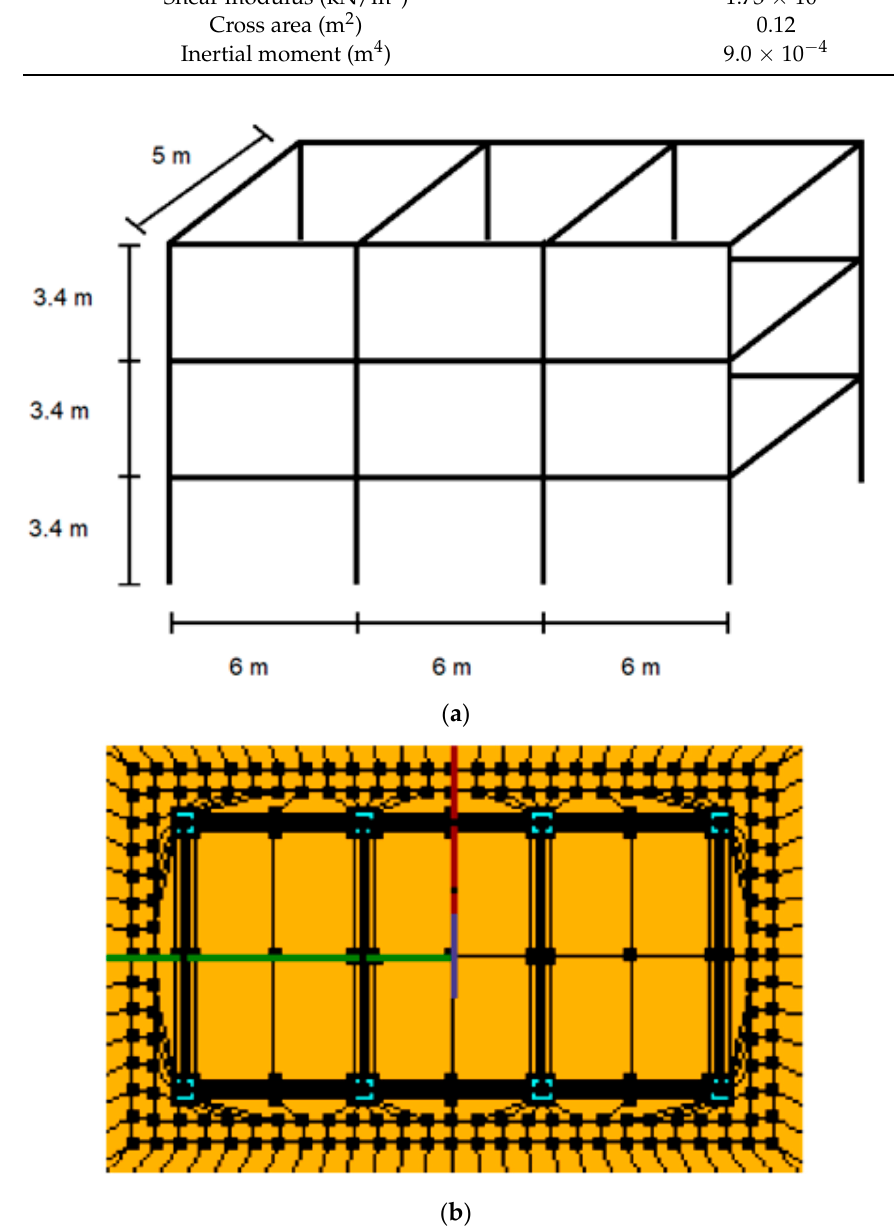
Figure 1. ( a ) The structure of the building used in the analyses (vertical view). ( b ) The structure of the building used in the analyses (plan view): slab dimensions are 28.4 m × 34.4 m × 0.5 m.